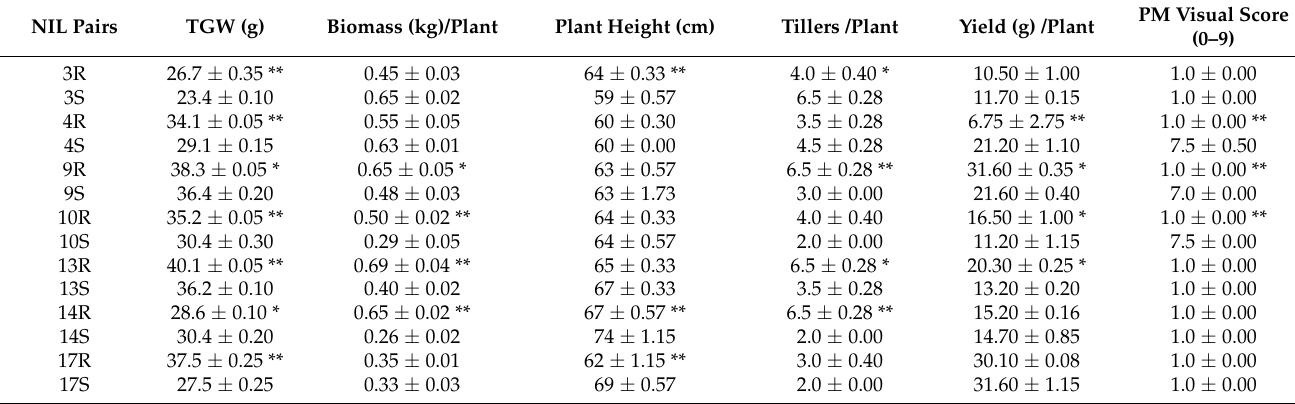
Table 2. Morphological trait differences between the isolines of each of the seven confirmed NIL